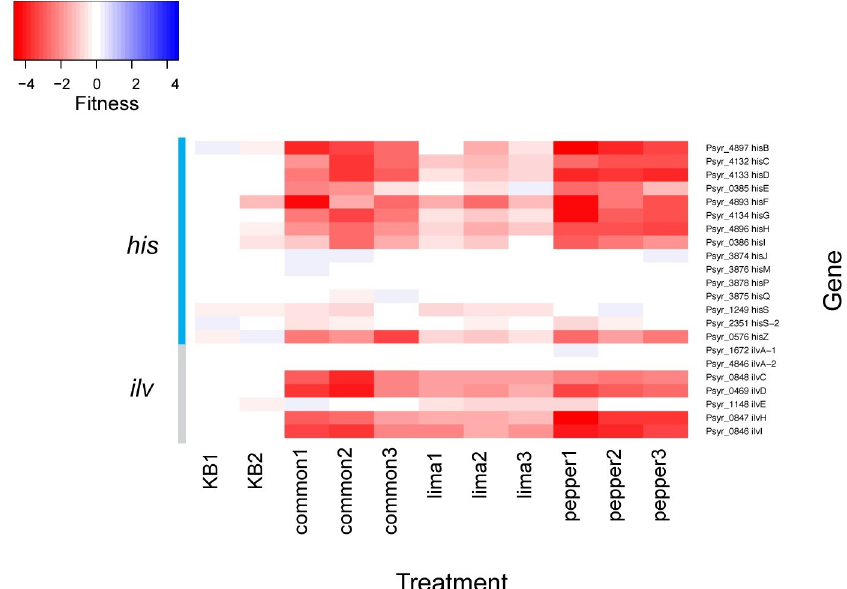
Fig 4. Apoplastic fitness contribution of histidine and isoleucine/valine biosynthetic genes. Genes hisD , hisH , and ilvHI had significantly different fitness values in different plant species by a Kruskal-Wallis test (p < 0.05).